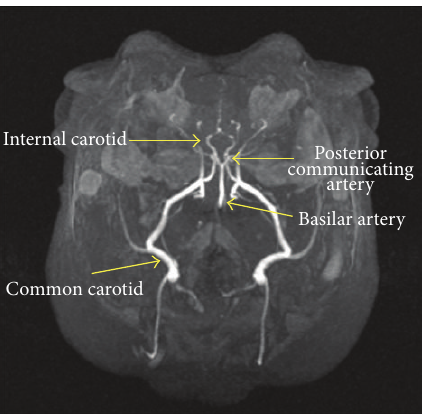
Figure 5: Blood vessels in the rabbit brain that were visualized by time-of-flight magnetic resonance angiography during our MRI studies and analysis of vessel diameters focused on the left and right commoncarotidarteries,thebasilarartery,theleftandrightinternal carotids arteries, and the left and right posterior communicating arteries.